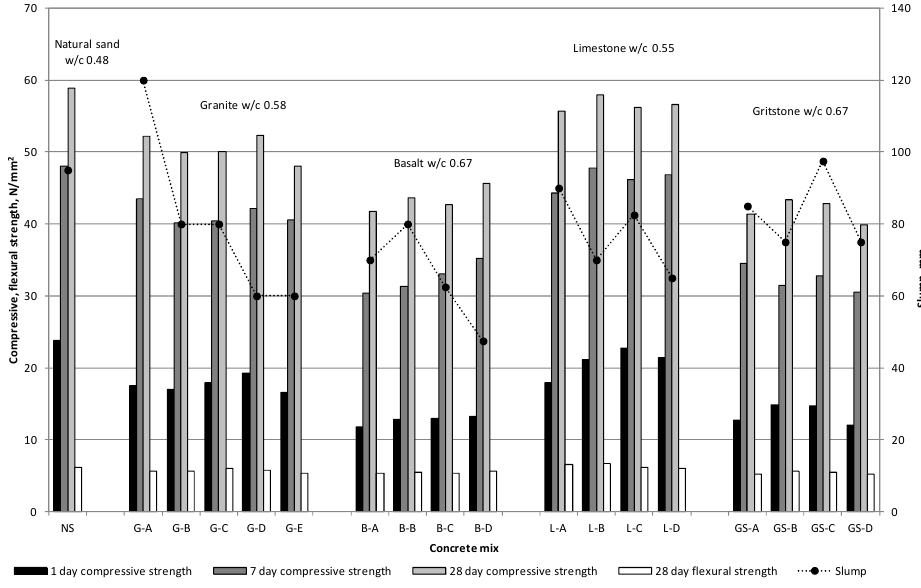
Figure 7. Slump controlled mix results.